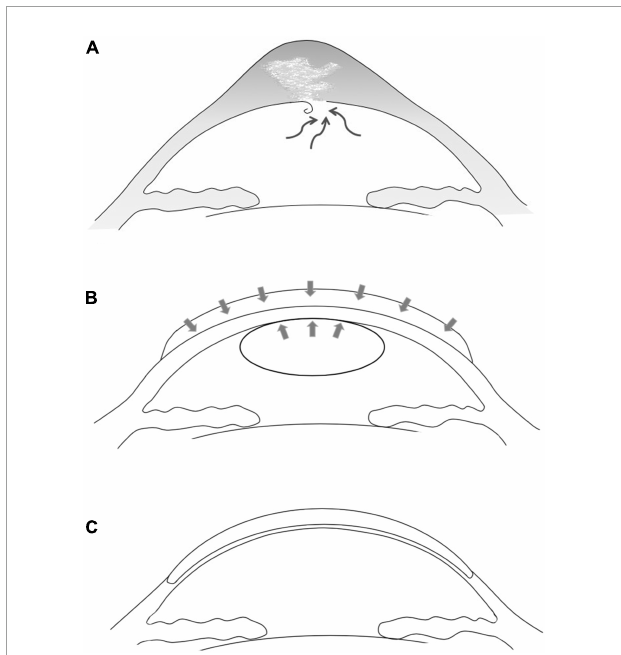
FIGURE1 Schematic drawing of the two-stage one-graft method. (A) Acute corneal hydrops in advanced keratoconus due to rupture of Descemet’s membrane and subsequent intrastromal fluid accumulation. (B) First-stage surgery. The pathological cornea was covered and pressed with an allogenic donor graft and the detached DM was pushed upward by an injected sterile air bubble. The disrupted DM was allowed to reset and heal, and the severe edema subsided rapidly. (C) Approximately 6 months later, the second-stage DALK was performed using the same donor